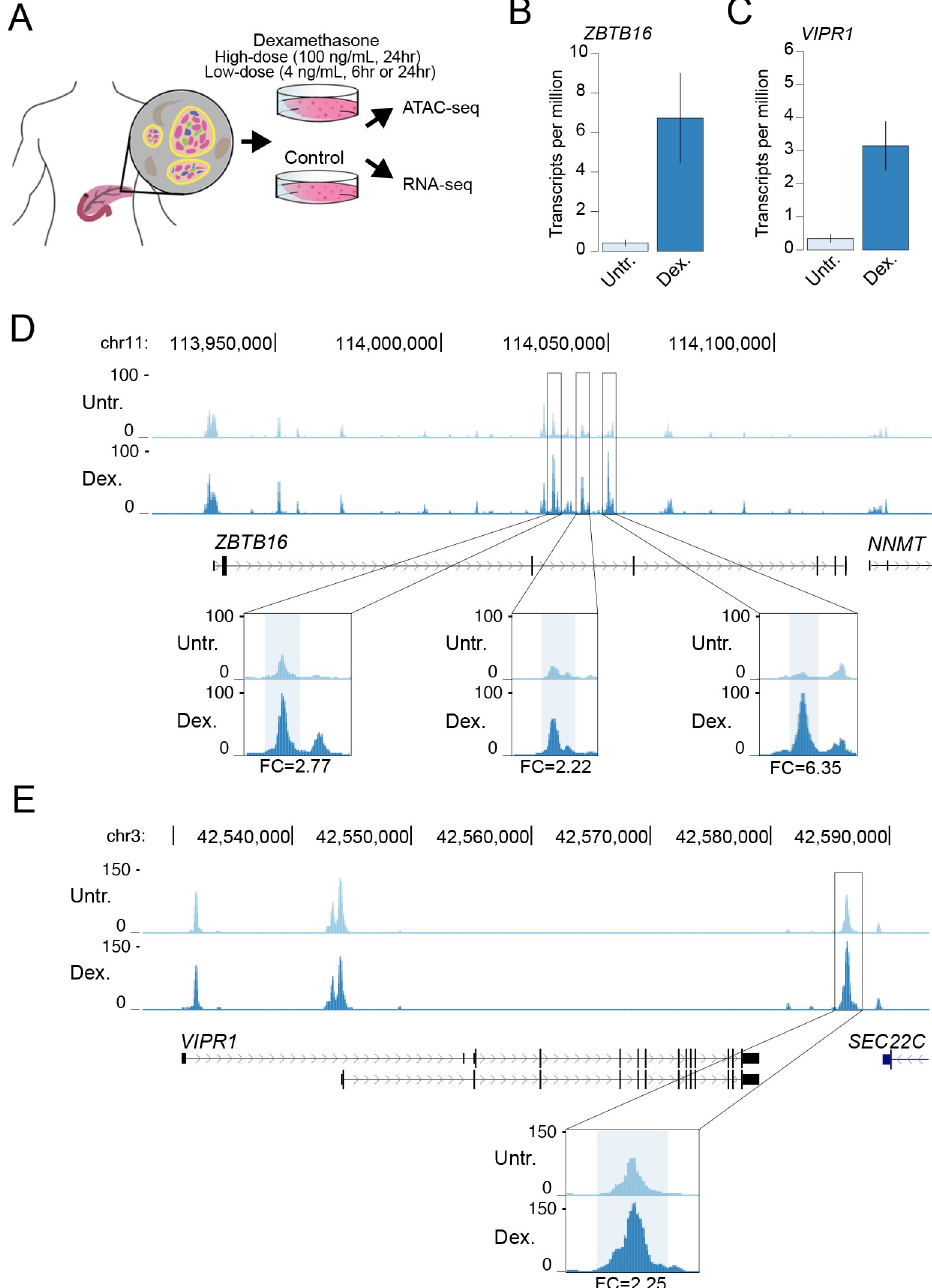
Fig 1. A map of gene regulation in pancreatic islets in response to glucocorticoid signaling. (A) Overview of study design. Primary pancreatic islet samples were split and separately cultured in normal conditions and including the glucocorticoid dexamethasone at either a high-dose (100ng/mL for 24hr) or low-dose (4 ng/mL for 6hr or 24hr) treatment, and then profiled for gene expression and accessible chromatin using RNA-seq and ATAC-seq assays. Genes with known induction in glucocorticoid signaling (B) ZBTB16 and (C) VIPR1 had increased expression in glucocorticoid-treated islets compared to untreated islets. Values represent mean and standard error. (D) At the ZBTB16 locus several accessible chromatin sites intronic to ZBTB16 had increased accessibility in glucocorticoid treated (Dex.) compared to untreated (Untr.) islets. (E) At the VIPR1 locus an accessible chromatin site downstream of VIPR1 had increased accessibility in glucocorticoid treated (Dex.) compared to untreated (Untr.) islets. Values in D and E represent RPKM normalized ATAC-seq read counts. Fold-change (FC) in accessible chromatin signal in glucocorticoid treatment compared to untreated indicated at highlighted sites. All results shown are for the high-dose treatment. https://doi.org/10.1371/journal.pgen.1009531.g001 PLOS Genetics | https://doi.org/10.1371/journal.pgen.1009531 May 13,